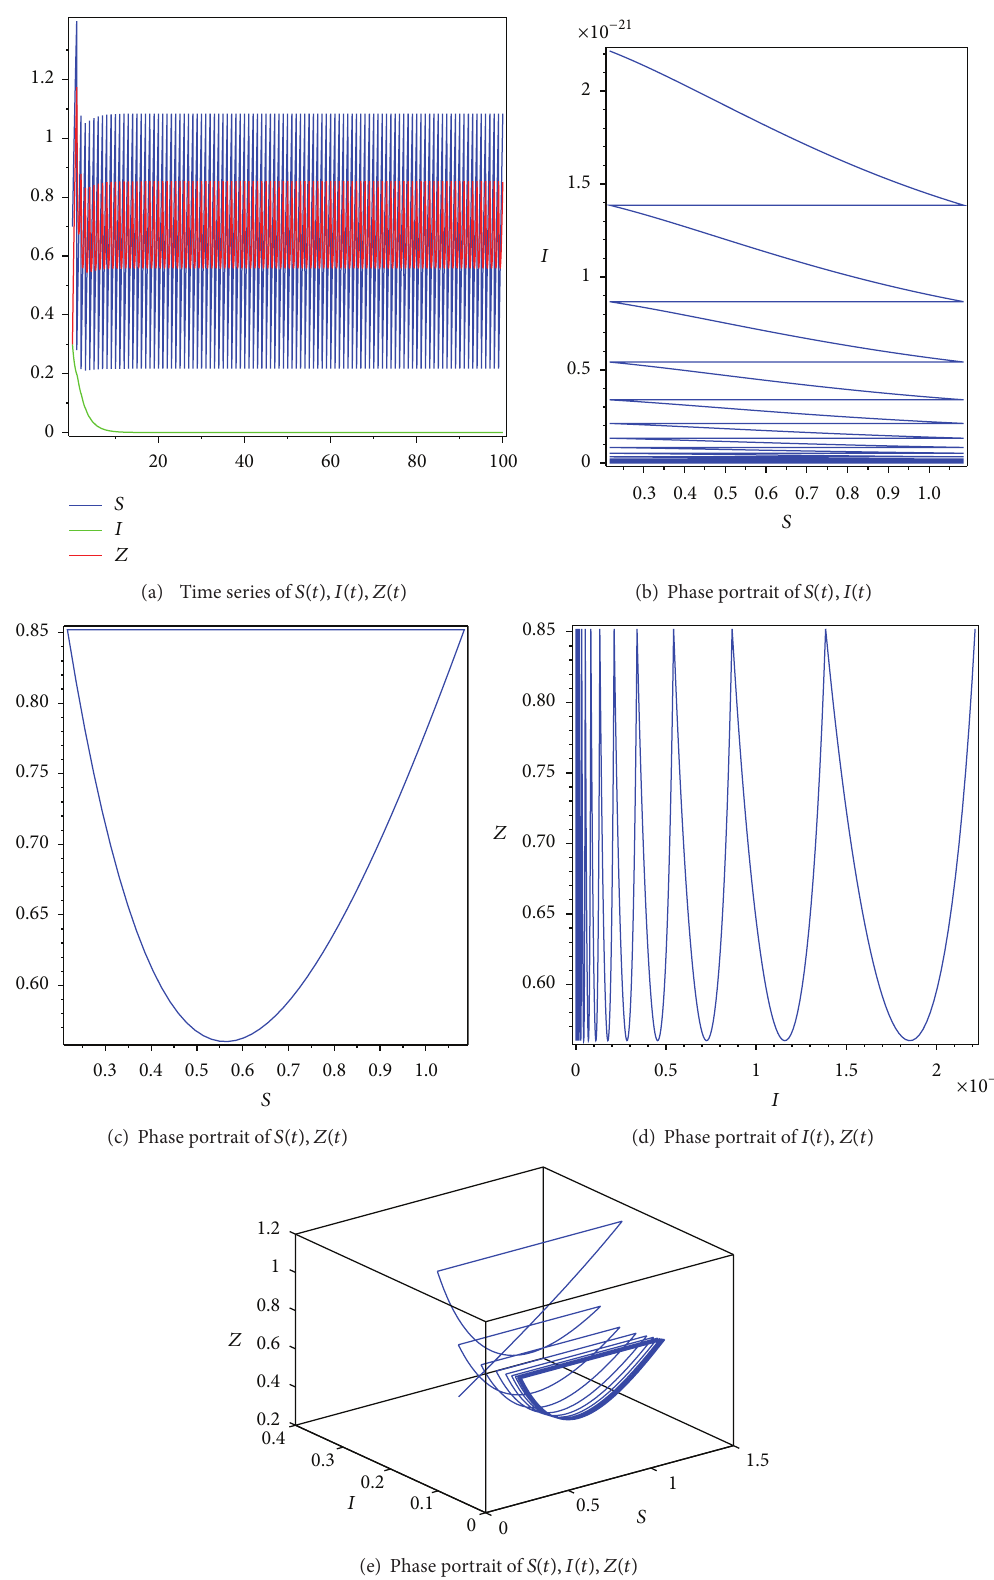
Figure 3: Illustration of basic behavior of system (9) on the threshold values R = 0.4155 < 1 , where Λ = 1, 𝜇 = 0.2, 𝛽 = 0.5, 𝑟 = 0.6, 𝑎 = 3, 𝑇 = 1 , and 𝛿 = 0.8